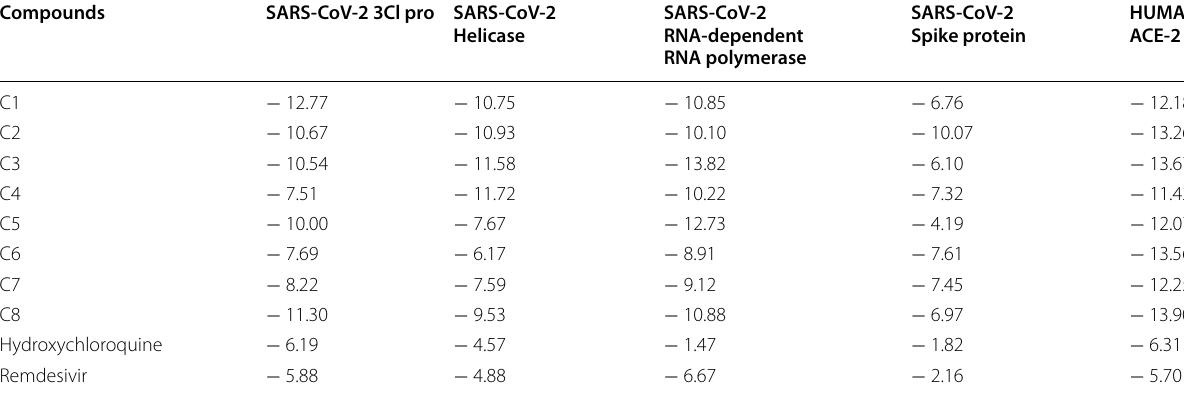
Table 1 Docking scores of top-scoring anthocyanins against SARS-CoV-2 targets